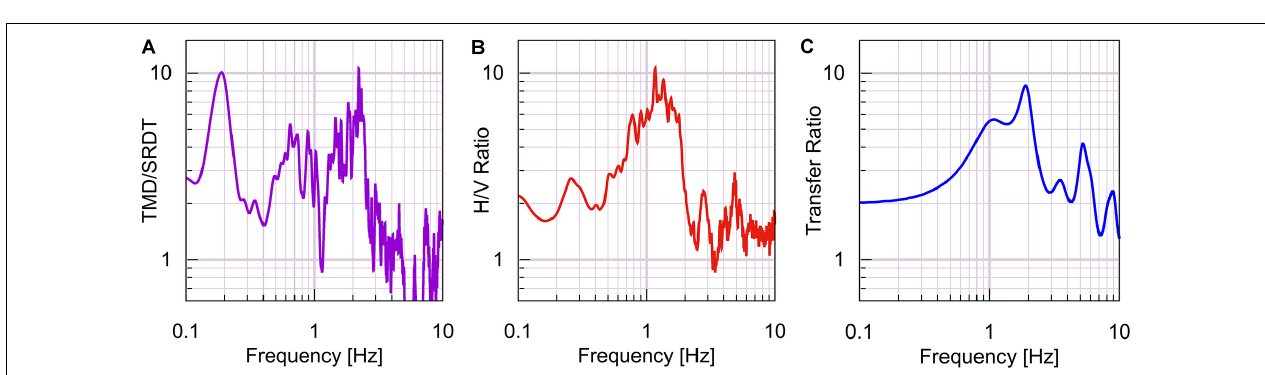
FIGURE 12 | (A) Ratio of HVSR of earthquake records at TMD and SRDT, (B) HVSR of single-point microtremor measurement at TMD, (C) 1-D transfer function from the inversion model at TMD.